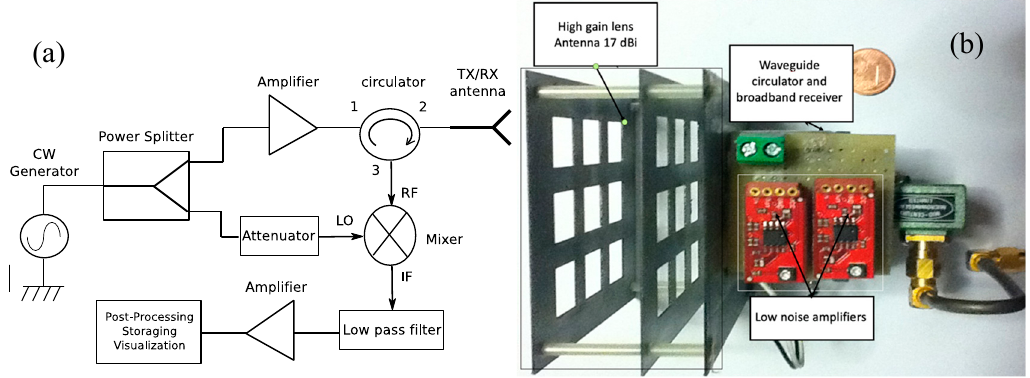
Figure 3. ( a ) Schema of a monostatic reader. ( b ) Photo of a monostatic reader with a waveguide ferrite circulator.